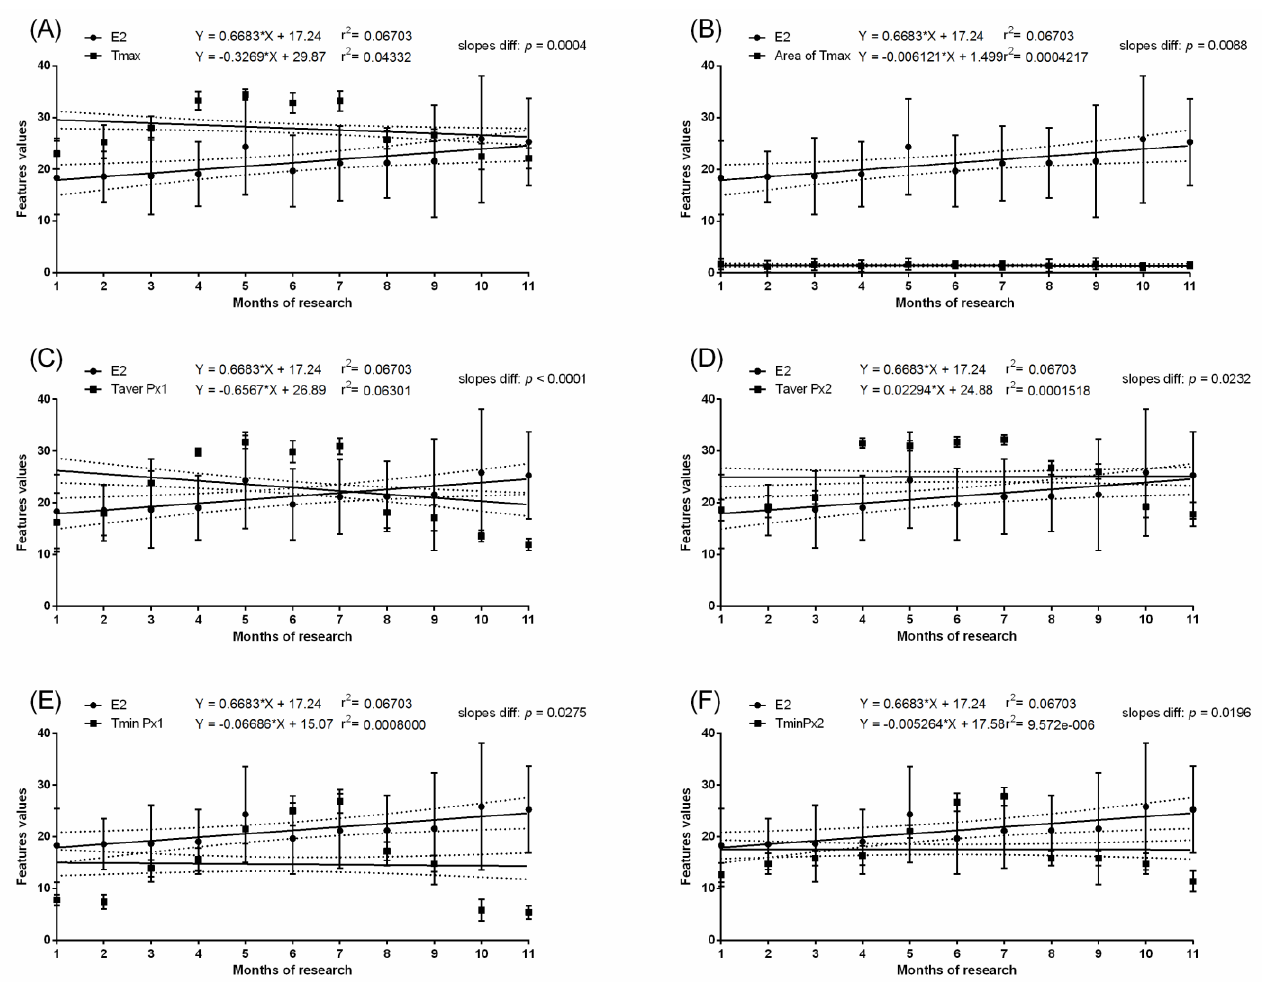
Figure 6. Linear regressions of 17-ß estradiol concentration in the serum and selected thermal features of the lateral surface of the abdomen in non-pregnant mares: the maximal temperature in Px1 and Px2 ( A ); the area with the highest temperatures in the range of 3 ◦ C ( B ); the average temperature in Px1 ( C ); the average temperature in Px2 ( D ); the minimal temperature in Px1 ( E ); the minimal temperature in Px2 ( F ).